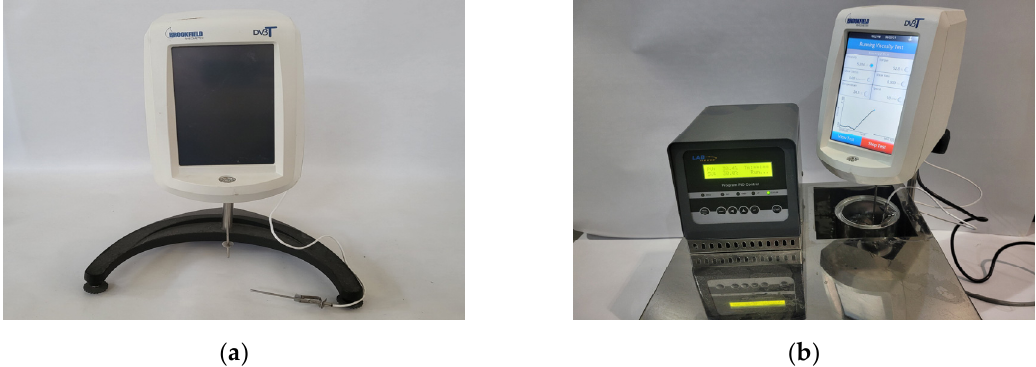
Figure 7. Viscosity measurement device and status: ( a ) viscosity measurement device; ( b ) viscosity measurement status.